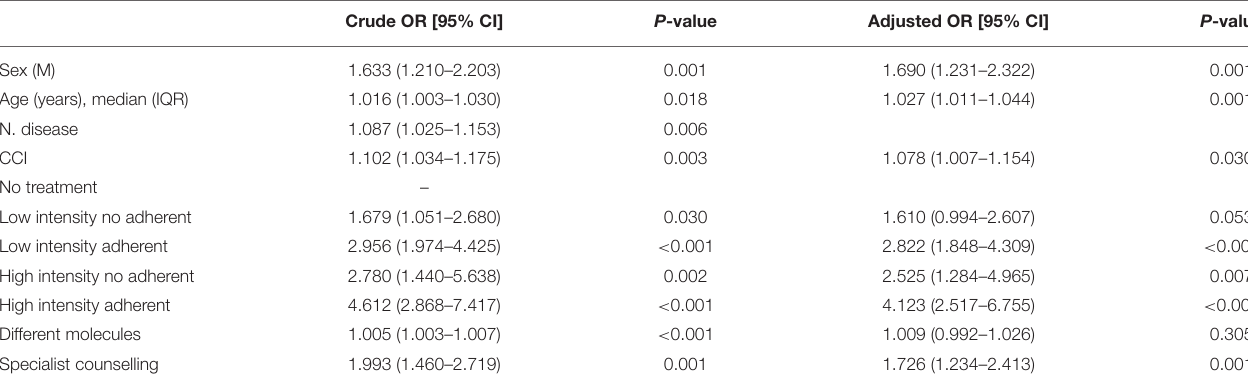
TABLE 3 | Predictive factors for reaching the low-density lipoprotein cholesterol (LDL-C) target in the patients with diabetes and at high and very-high